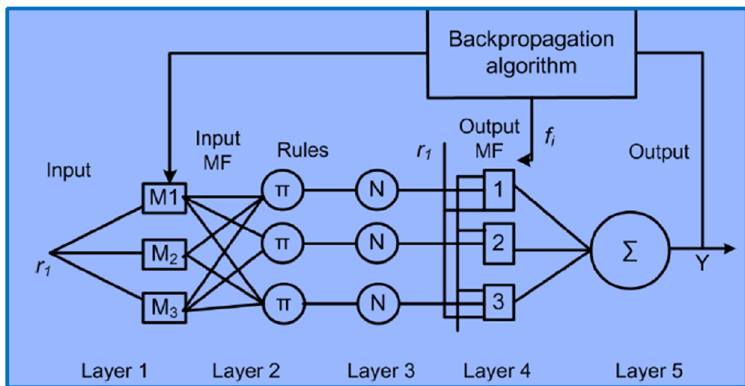
Figure 4. Sugeno inference system based ANFIS structure.